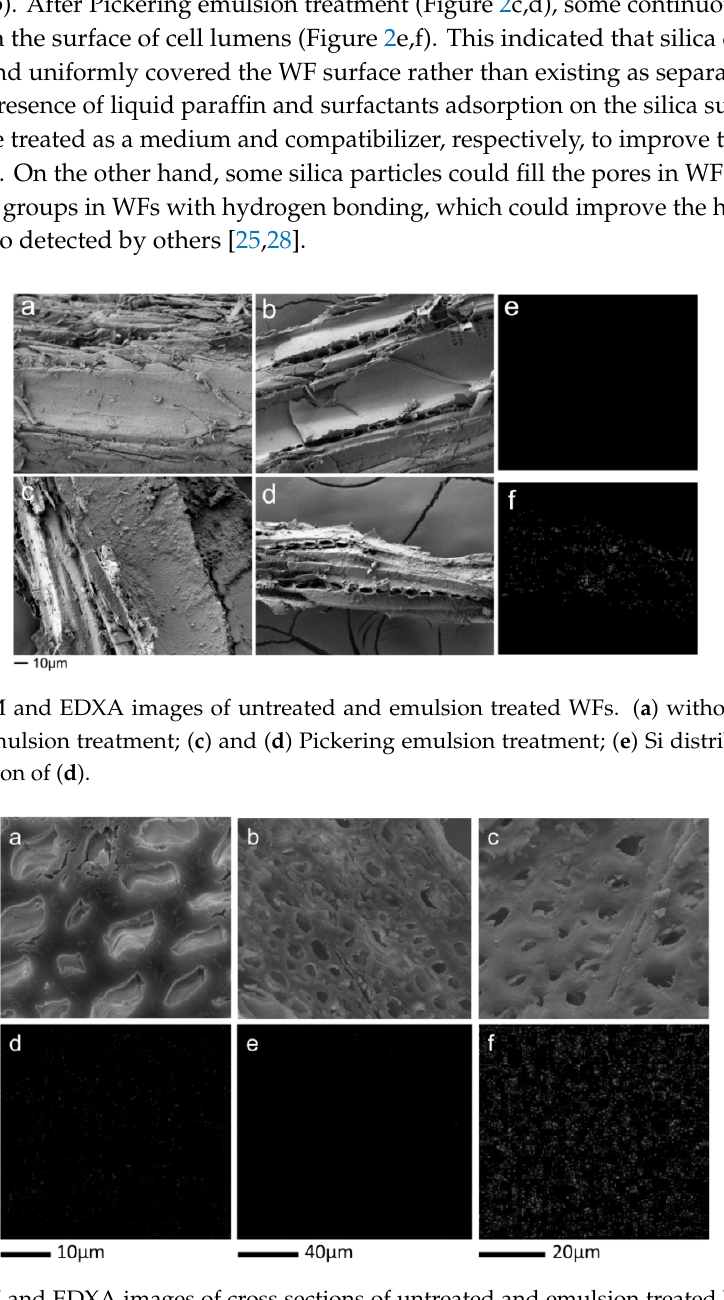
Figure 3. SEM and EDXA images of cross sections of untreated and emulsion treated WFs. ( a ) and ( d ) without treatment; ( b ) and ( e ) paraffin emulsion treatment; ( c ) and ( f ) Pickering emulsion treatment.